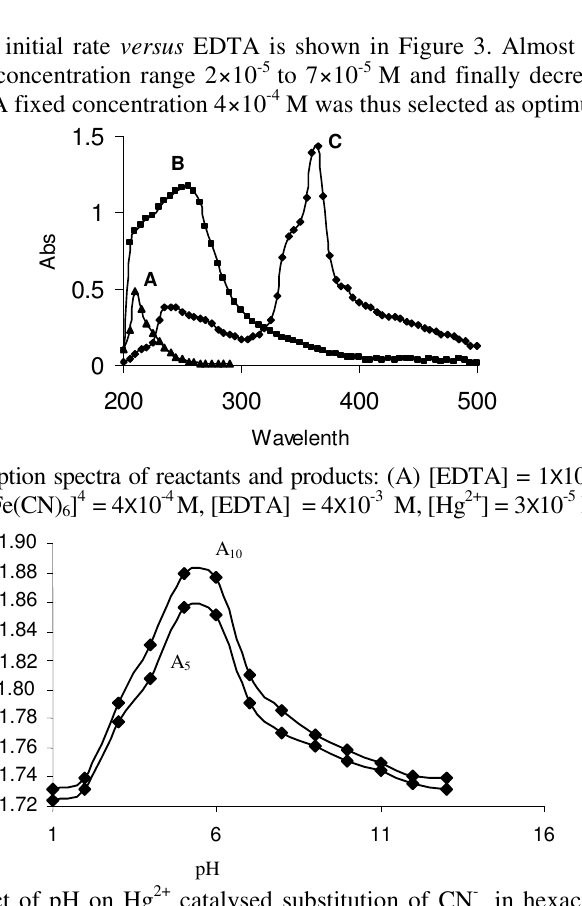
Figure 2. Effect of pH on Hg 2+ catalysed substitution of CN - in hexacyanoferrate(II) by EDTA ion at [Fe(CN) 64- ] = 5 X 10 -3 M, EDTA = 5 X 10 -5 M, [Hg 2+ ] = 3 X 10 -5 M, Temp = 25 0 C and I = 0.1 M (KNO ). 3